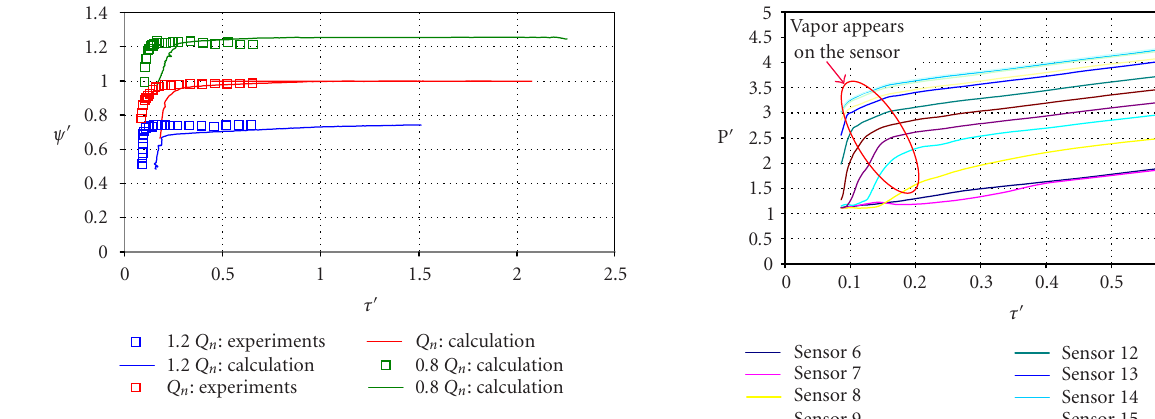
Figure 9: Comparisons between numerical and experimental head drop charts.